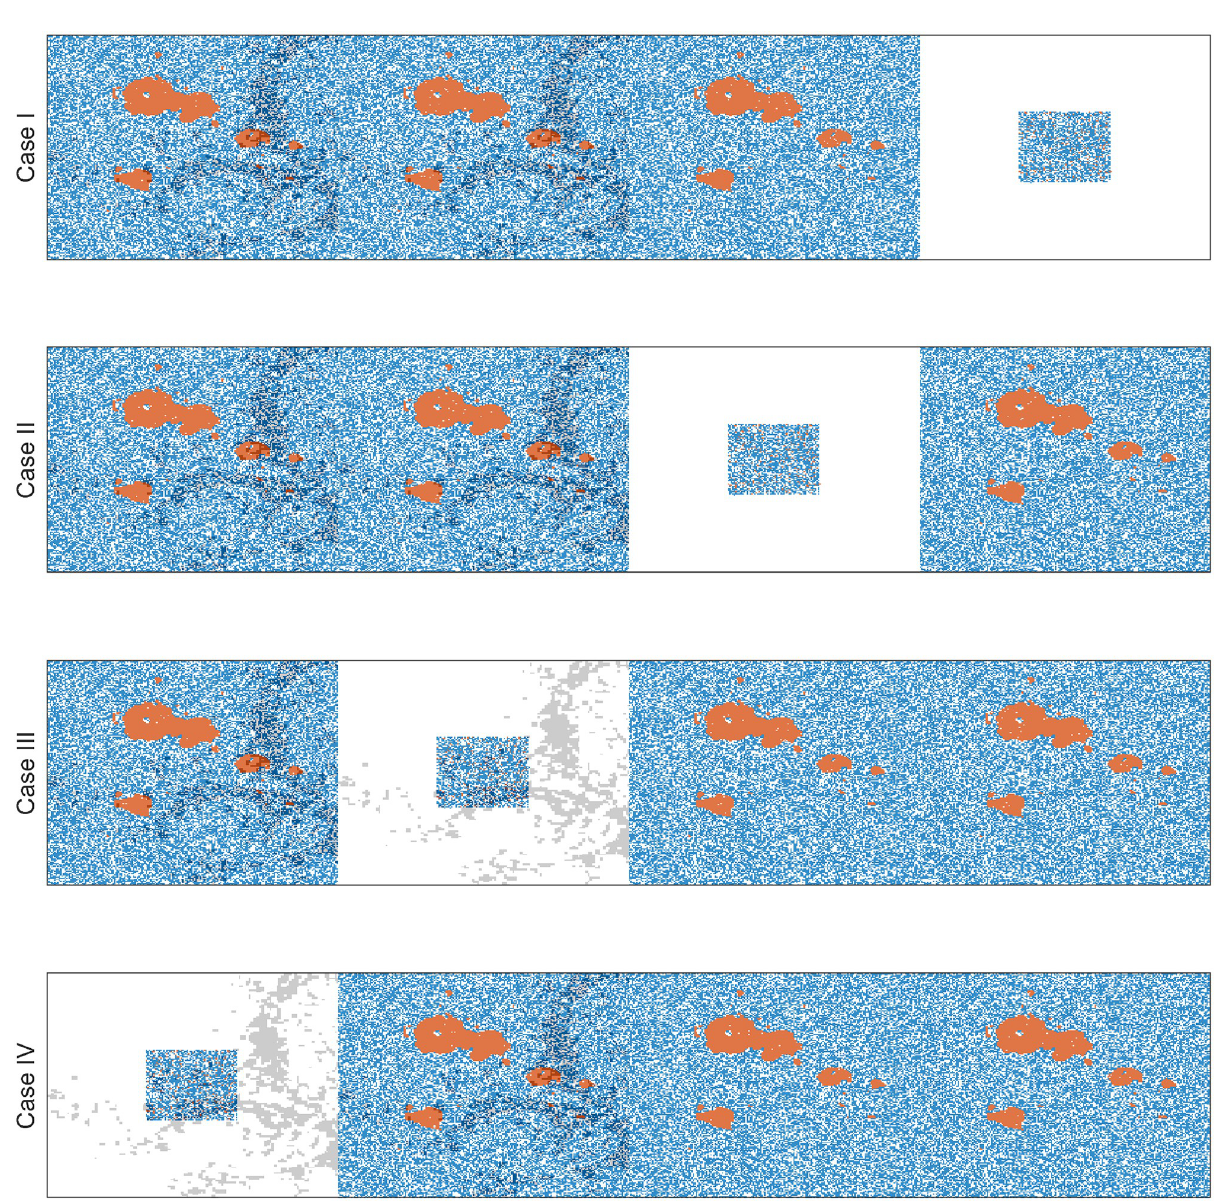
Fig 12. Initial cell configurations for the four cases with an invisible clumped metastasis. The red, blue, and white dots correspond to R-cells, S-cells, and empty sites. The gray dots shows the sites accompanied by